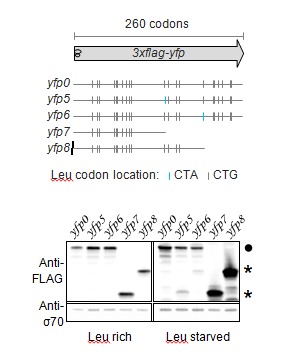
Western blot to demonstrate abortive termination at stall-inducing codons during leucine starvationDOI: